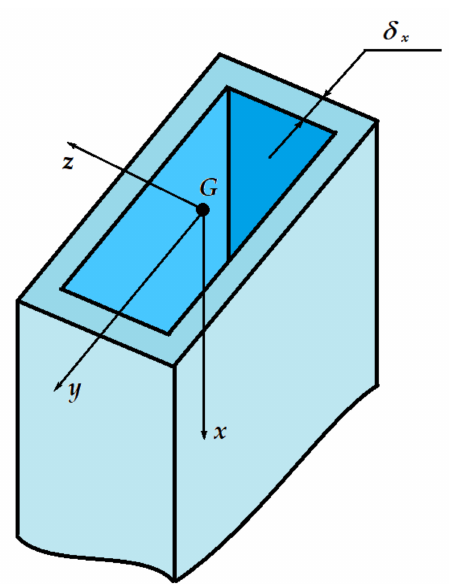
Figure 1. Beam with rectangular-hole